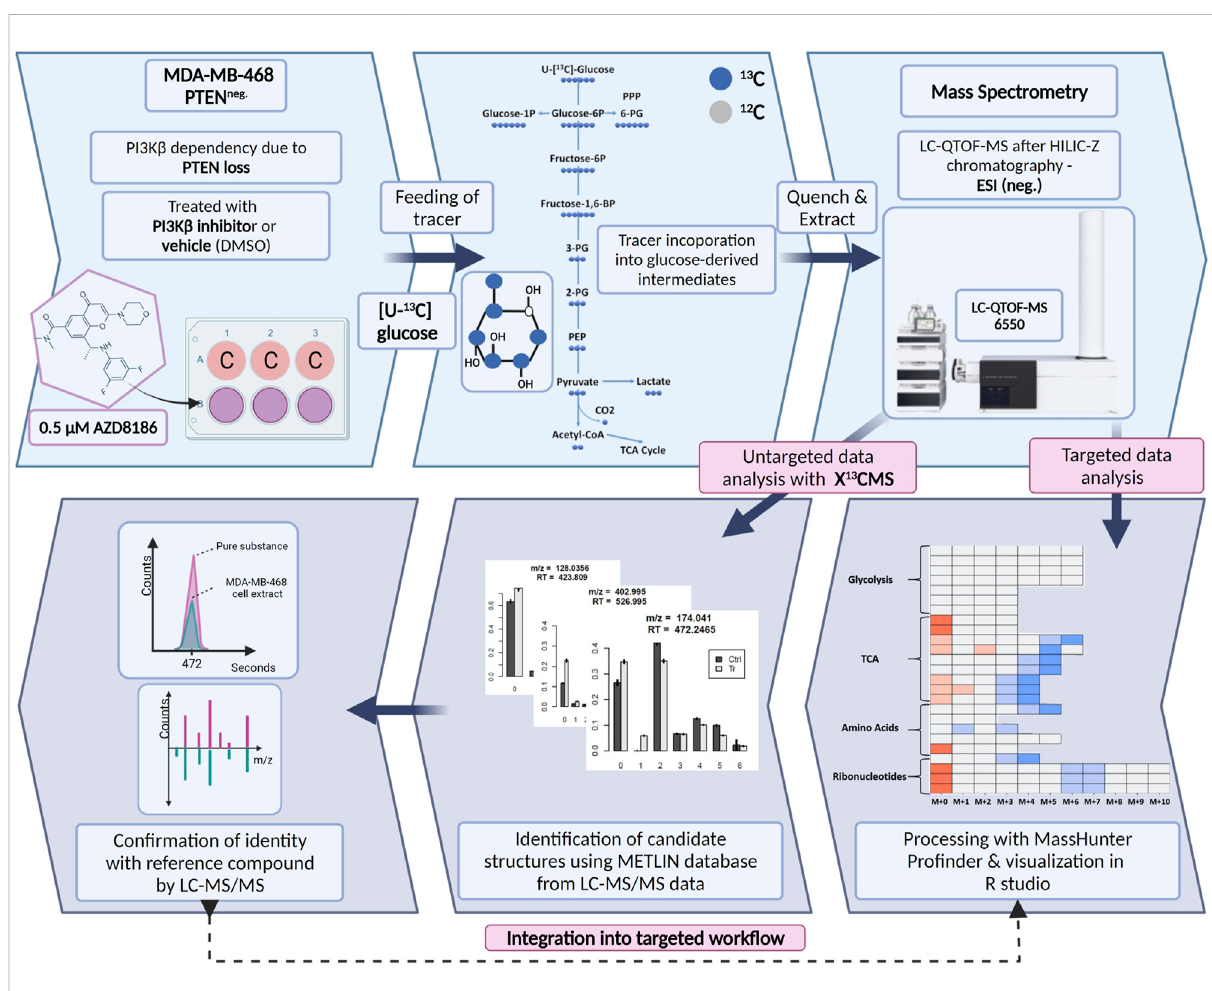
FIGURE 1 Schematic of SIRM work fl ow for tracer experiments. Cells were cultivated in [U- 13 C] glucose tracer containing RPMI medium supplemented with 0.5 µM AZD8186 or vehicle. After 1,3, 6,and 24 hcells wereharvested according to an optimized quenchand extraction protocol.Cell extracts weremeasuredwithLC-QTOF-MSandtheobtaineddataanalyzedinatargetedaswellasuntargetedmanner.Targeteddataanalysiswasperformed with the MassHunter Pro fi nder software environment and harnessed a metabolite library with corresponding sum formulas, masses, and retention times. Untargeted analysis with X 13 CMS (Huang et al., 2014) produced a list of differentially labeled metabolites between drug treated and control conditions. Fragmentspectra fromunlabeledcellextracts allowedtheassignmentofpotential candidate structures fromtheX 13 CMSfeature list. Metabolite identity was con fi rmed by the corresponding pure substance, its retention time, and fragment spectra. Finally, the identi fi ed metabolites were integrated into the targeted SIRM work fl